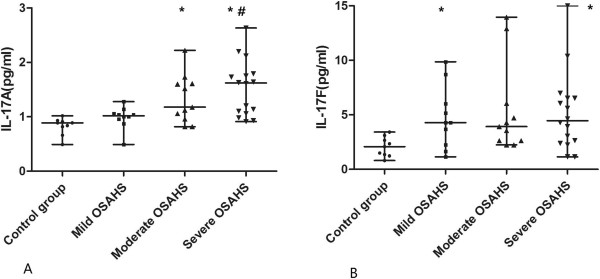
Serum level of IL-17A and IL-17 F were assessed by ELISA. The data are presented as median (minimum, maximum). * p < 0.05 versus control group; # p < 0.05 versus mild OSAHS group.